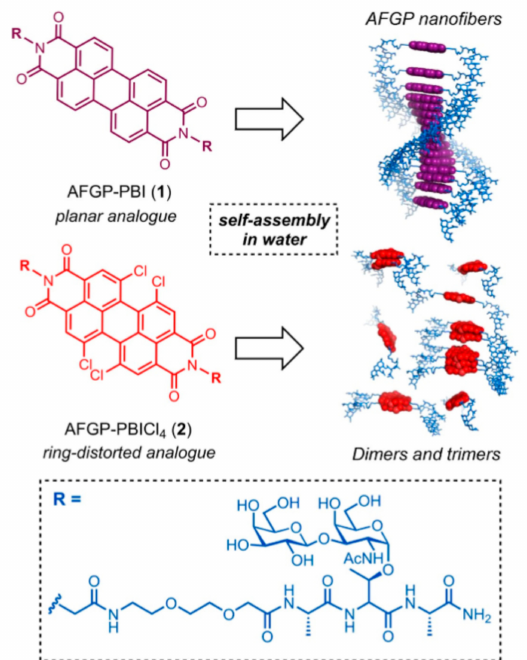
Figure 10. Scheme of the self-assembly induced by perylene bisimides and synthetic structure of the AFGP analogues attached. Reprinted with permission from Chemistry 2018 , 24 , 7834–7839